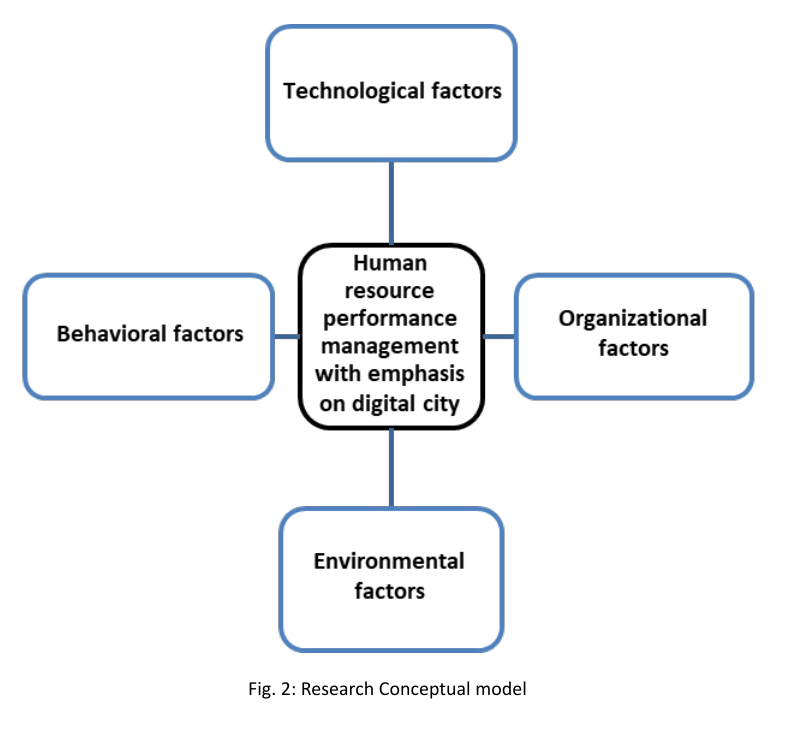
Fig. 2: Research Conceptual model